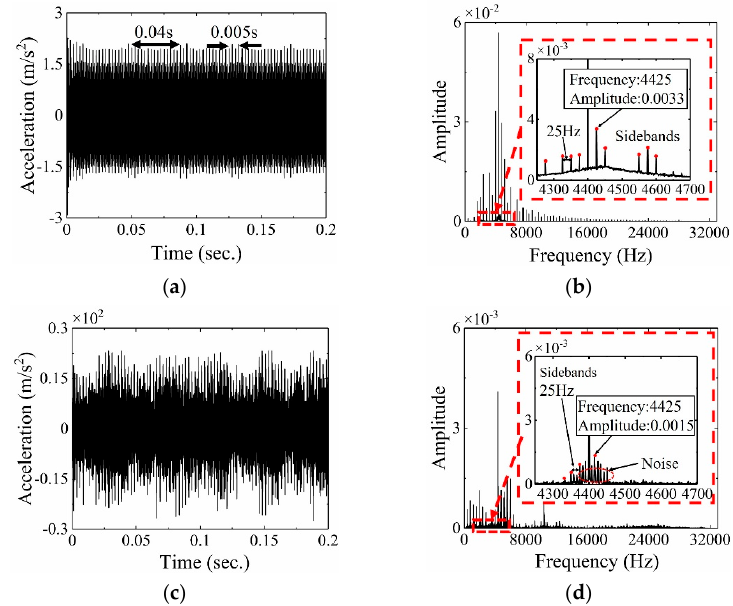
Figure 15. The simulated and experimental signal in the meshing line direction (two teeth with spalling fault, which are separated by one healthy tooth): ( a ) simulated signal, ( b ) simulated frequency signal, ( c ) experimental signal, and ( d ) experimental frequency signal.